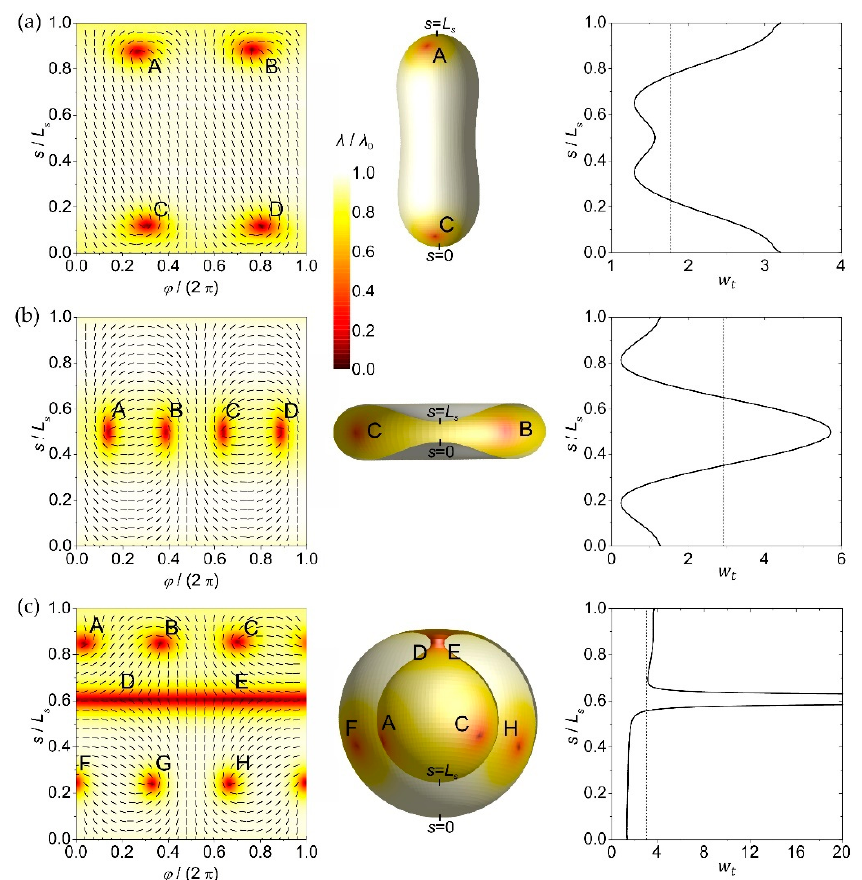
Figure 3. Dependence of w t on the arc length s upon increasing the relative weight of the extrinsic term 2 k e / k i for ( a ) prolates, ( b ) oblates and ( c ) stomatocytes. Red lines denote global and local maxima of w t . Shell profiles are given within graphs for each shape.